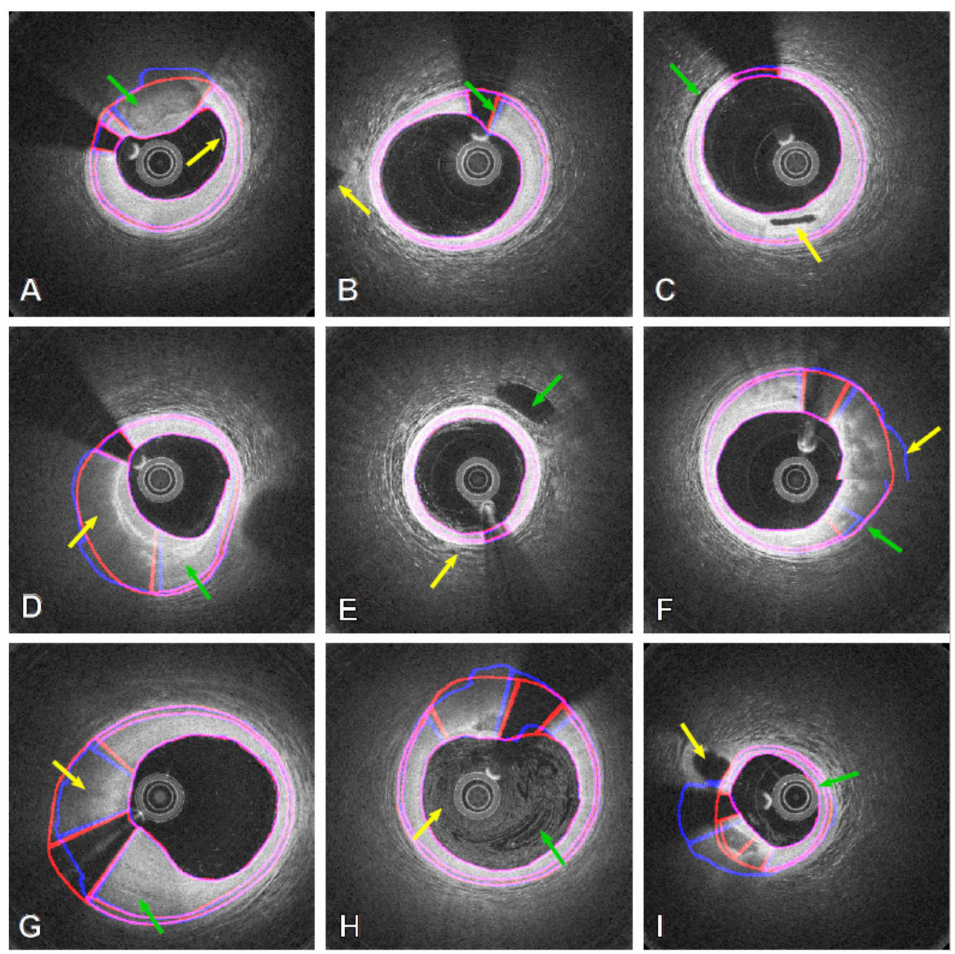
Figure 6. Results obtained from both the automatic method (blue contours) and expert annotation (red contours) in PS-OCT images with the automatic method showing robustness in difficult